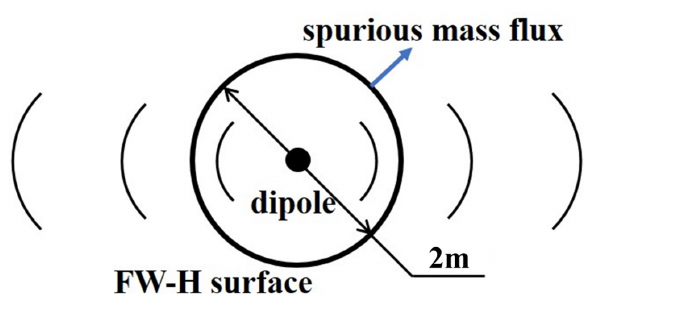
Figure 1. Schematic of the unsteady dipole source with spurious mass flux on the FW–H boundary. In this section, the frequency ω e , as distinct from the frequency of the unsteady dipole ω 0 , is taken to be 5 π rad/s. The amplitude A e is defined to be 1 × 10 − 6 m/s and 1 × 10 − 5 m/s, corresponding to the maximum instantaneous mass fluxes 1.26 × 10 − 5 kg/s and 1.26 × 10 − 4 kg/s, respectively. Since the mass inside the closed FW–H bound- ary is 12.56 kg, the maximum relative spurious mass change per second is 0.0001% or 0.001%, depending on whether the averaged velocity divergence is 1 × 10 − 6 /s or 1 × 10 − 5 /s, respectively.